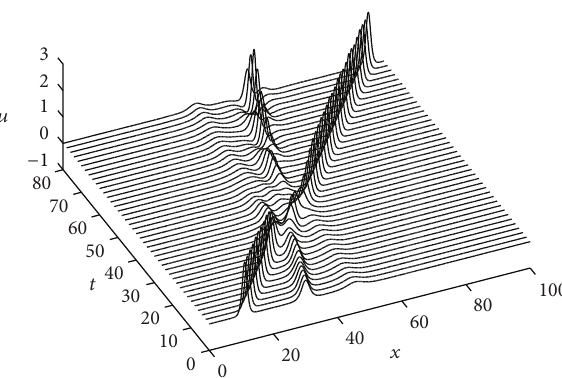
Figure 10: Birth of solitons with parameters 𝑎 = 0.5 and 𝑏 = −3.0 . Table 5: Three solitons interaction: the conserved quantities.